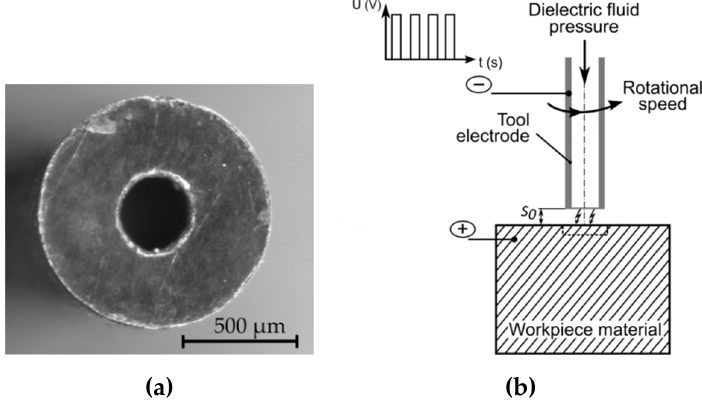
Figure 3. ( a ) The tip of the tool electrode; ( b ) the scheme of the electrical discharge drilling (EDD) process.